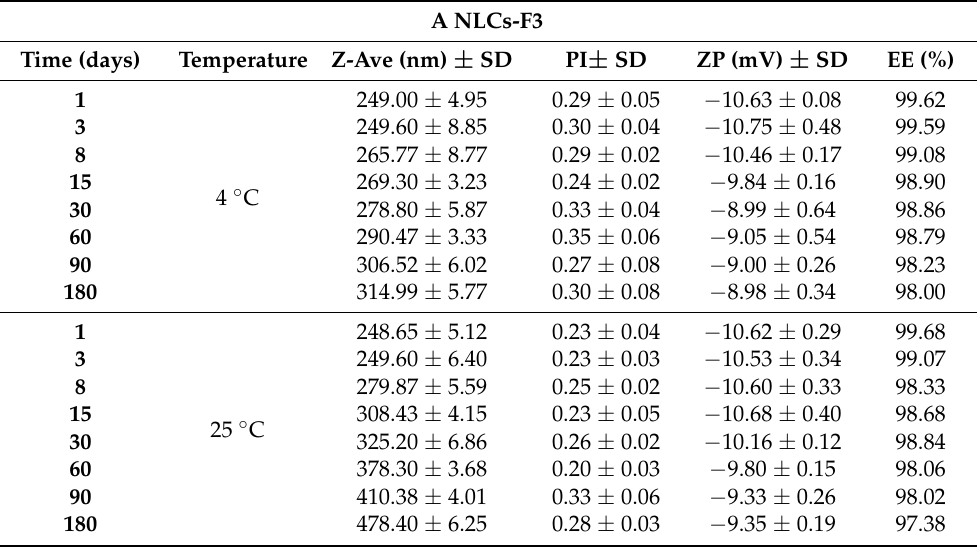
Table 2. Stability of the selected NLCs at different storage conditions. A